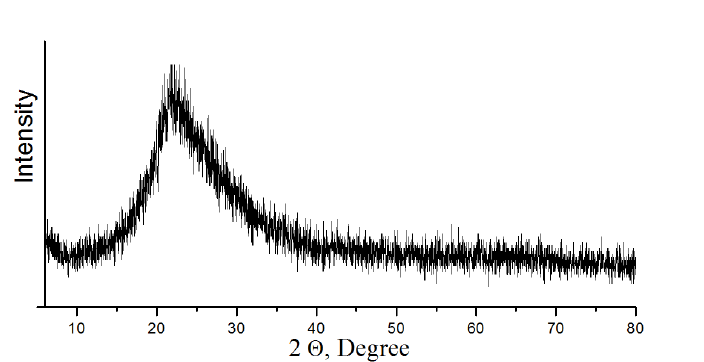
Figure 4. Powder X-ray diffraction pattern of composition (heat treatment at 500 °C).